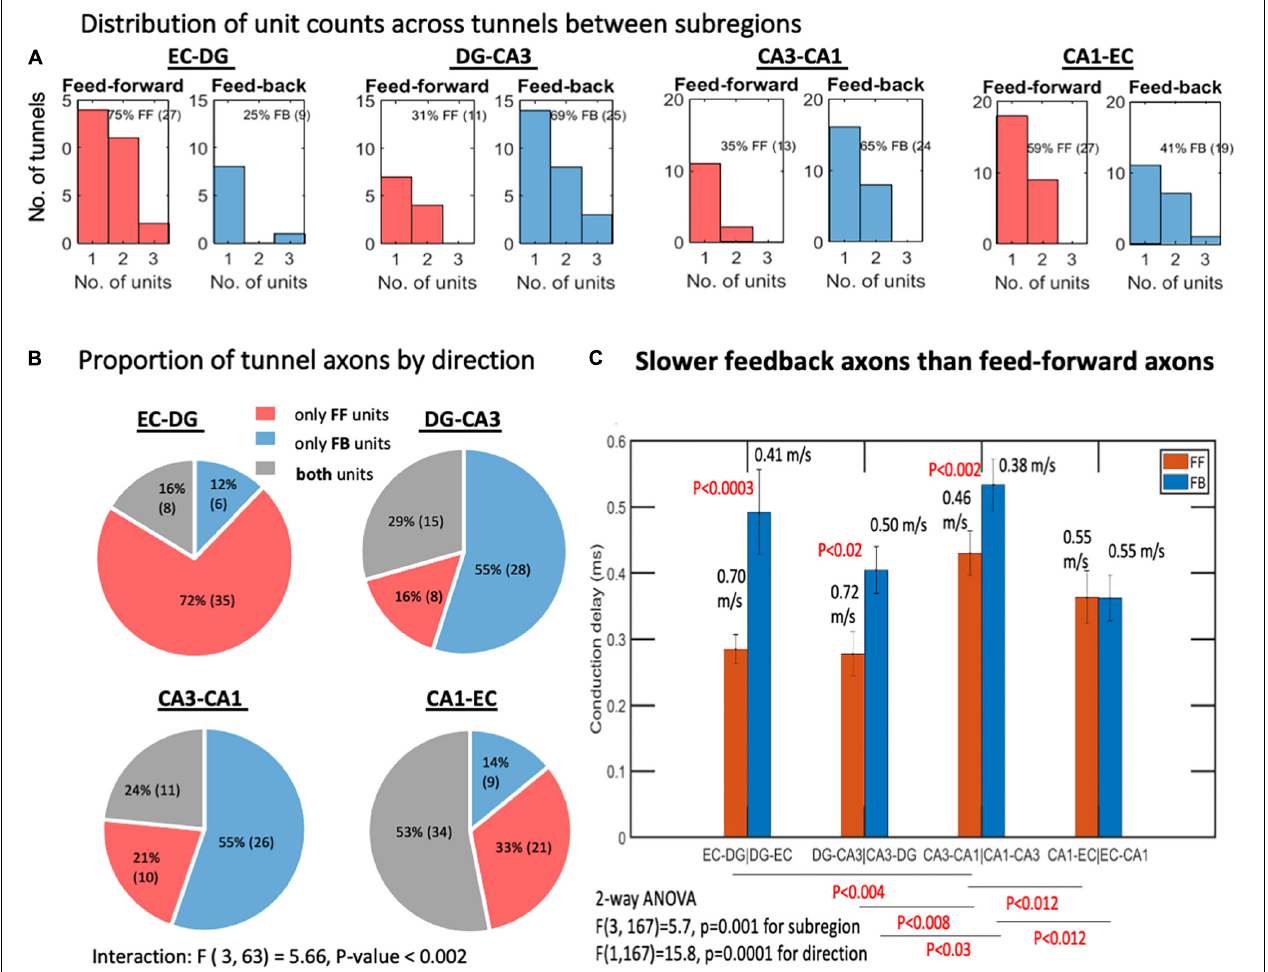
FIGURE 2 | Feed-forward (FF) and feedback (FB) units between the subregions. (A) Interregional axons by subregions that they connect. Most tunnels were populated by a single axon. Two or three axon units were also detected. Spike sorting and subsequent determination of direction of propagation yield substantial numbers of feedback units in each subregion ( n = 8 arrays). (B) EC-DG tunnels predominantly contain feed-forward axons, implying that the direction of information flow is predominantly feed-forward, whereas DG-CA3 and CA3-CA1 contain significantly more tunnels with feedback axons or bidirectional (containing both FF and FB units). (C) Slower feedback velocities of spike propagation than feed-forward axons by 2-way ANOVA with Tukey HSD subtests of the confidence interval overlap. p -values above bars are for the feed-forward vs. feedback comparison. Bars are mean and 95% confidence intervals of conduction delays. Corresponding conduction velocities are also indicated above bars for the 0.2-mm electrode spacing. N = 10